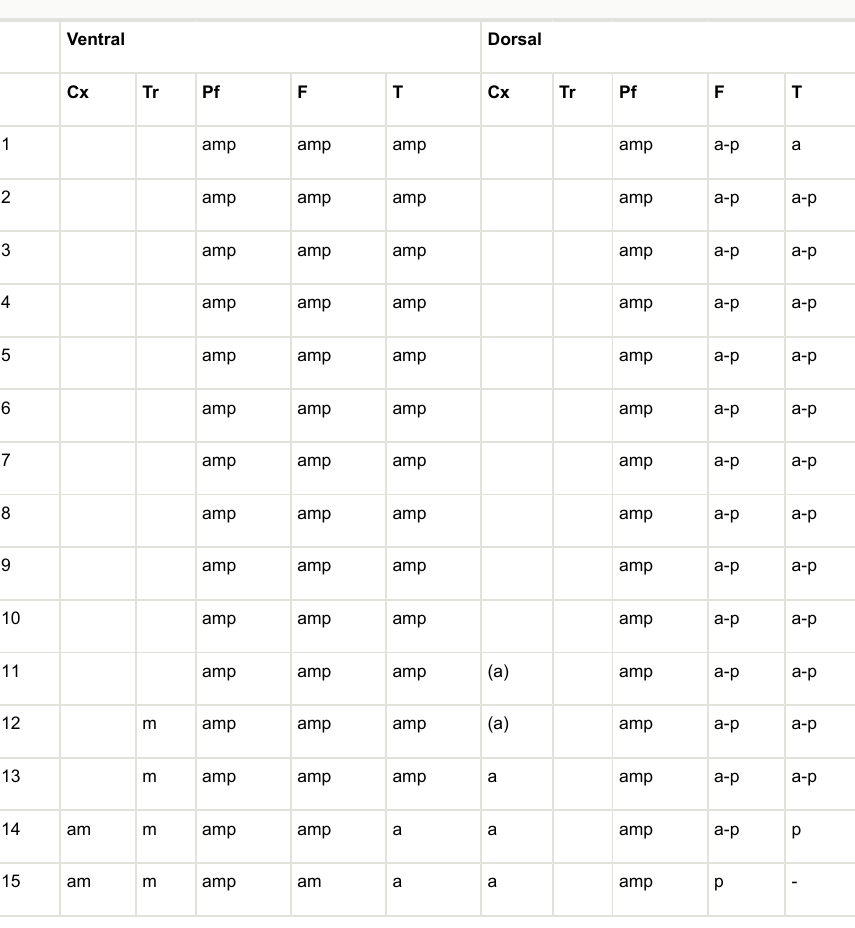
Plectrotaxy of E. cavernicolus Komerički & Stoev sp. n., female